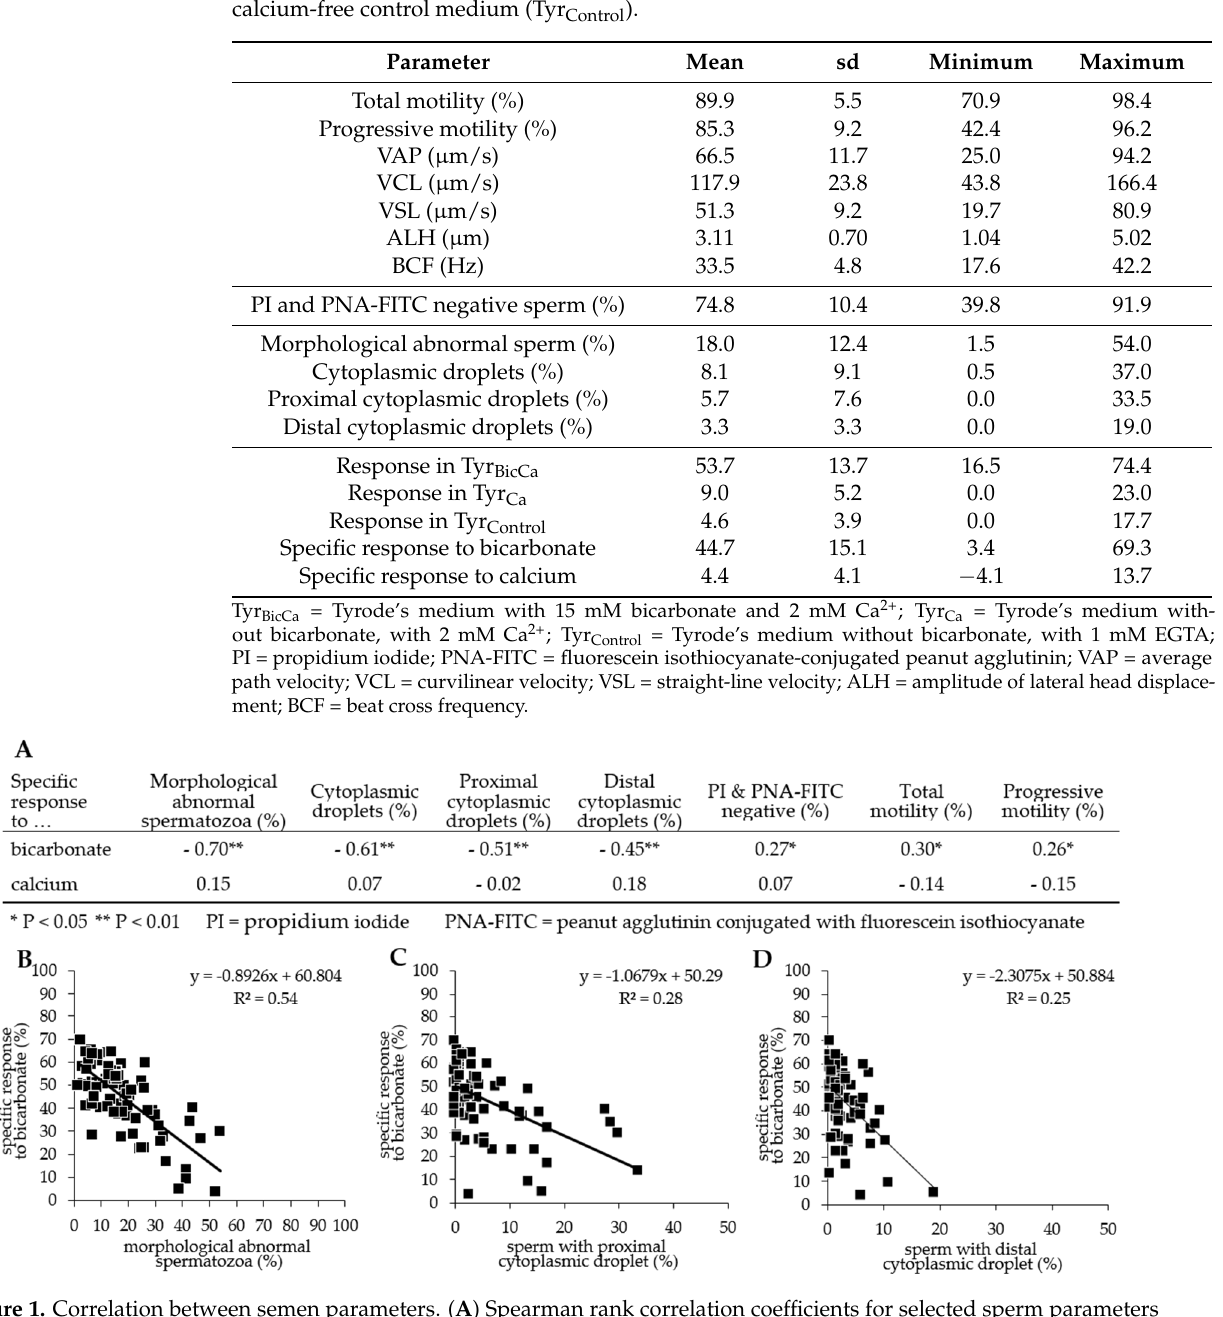
Table 1. Quality parameters for semen samples after 24 h storage at 17 ◦ C. Semen samples had been stored in Beltsville Thawing Solution (n = 78 boars). The responsiveness of sperm in the calcium influx assay was calculated based on the propidium iodide and Fluo-3 low sperm population